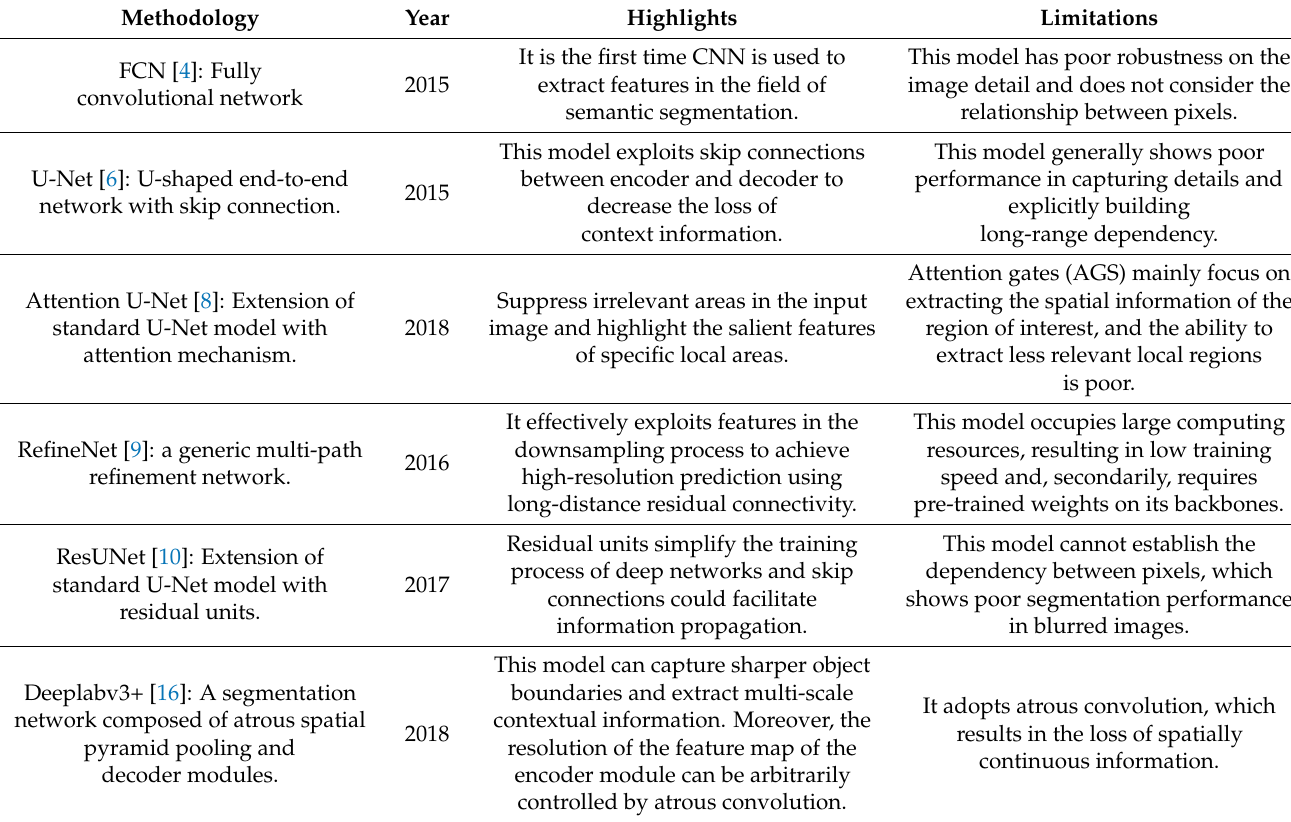
Table 1. A summary of the segmentation method mentioned in the